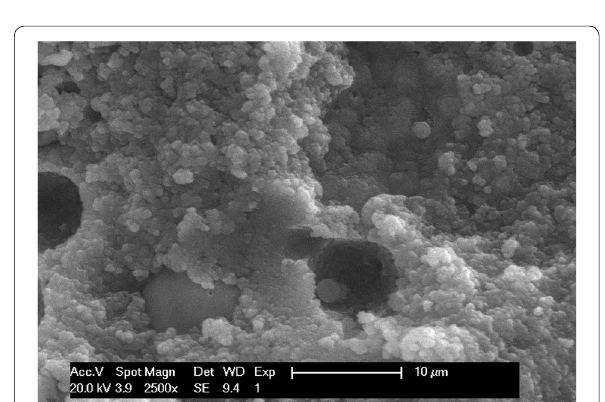
Fig. 9 Outer layer of unburned particles in